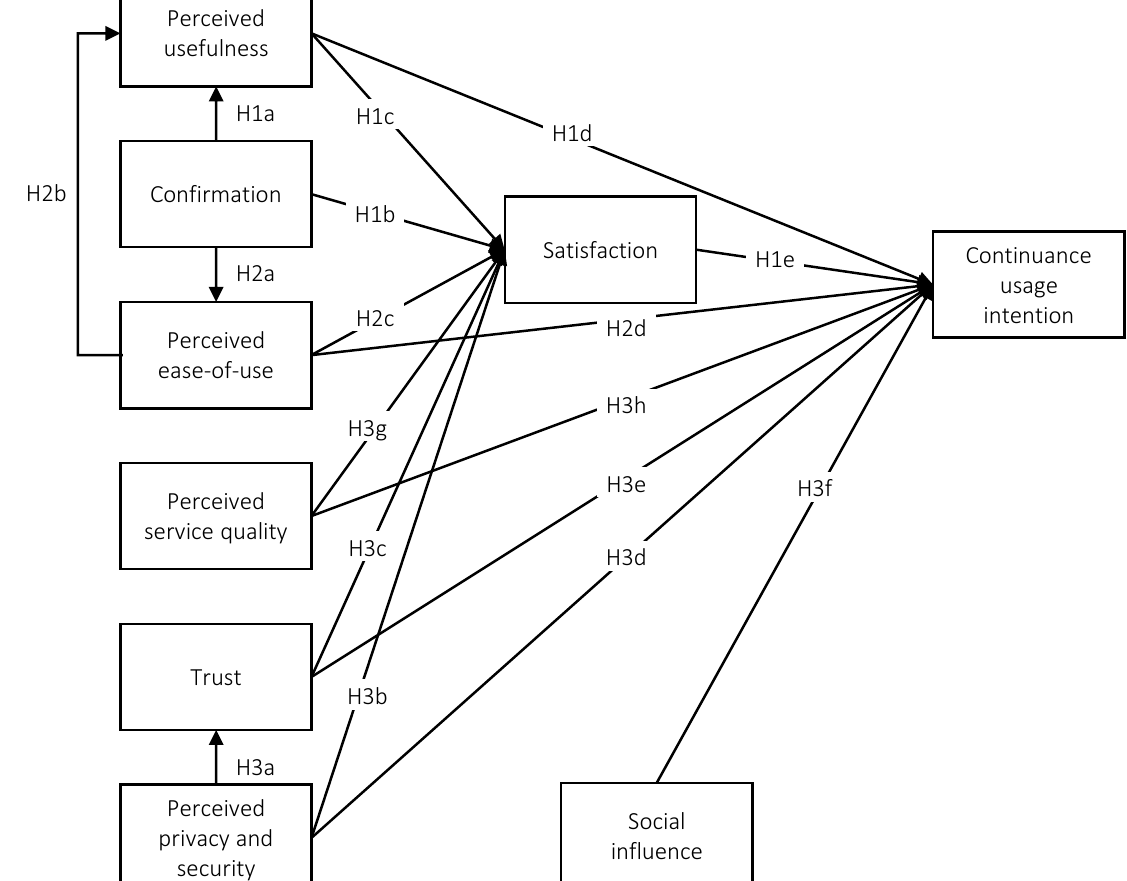
Figure 1. Research framework of the